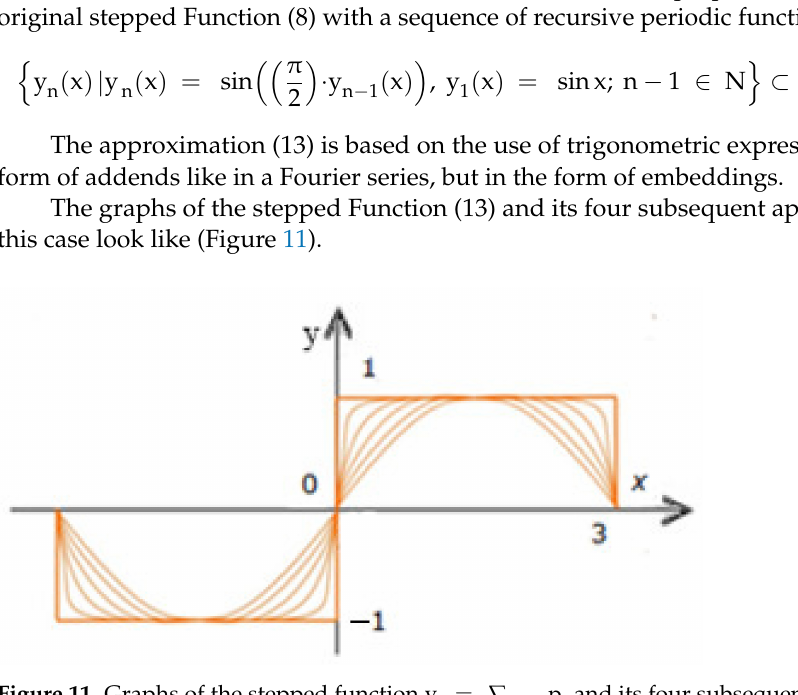
p and its four subsequent approximations i i ≺ x